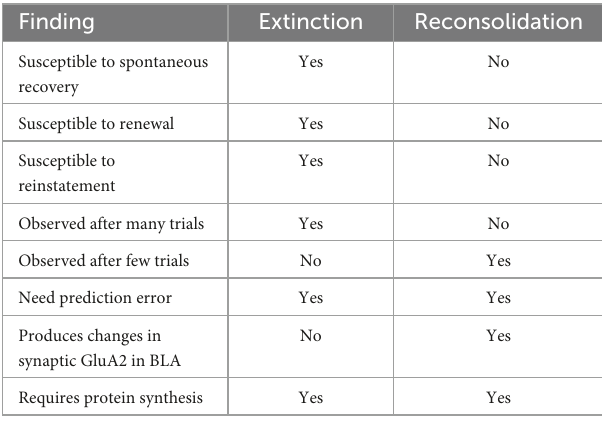
TABLE 1 Brief overview summarizing similarities and differences between extinction and